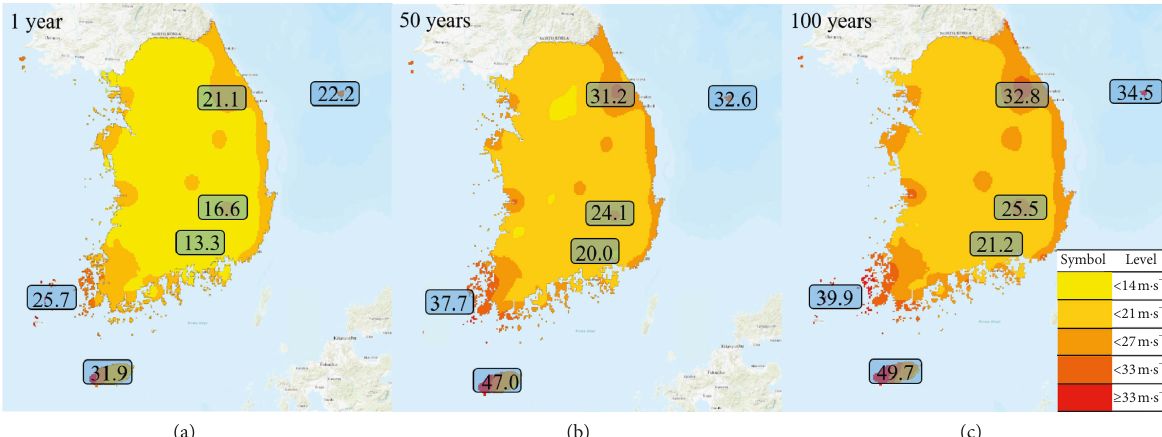
Figure 8: Gumbel distribution-based estimated distributions of daily maximum wind speeds occurring on the Korean peninsula excluding typhoon impacts for the recurrence periods of 1year (a), 50years (b), and 100 years